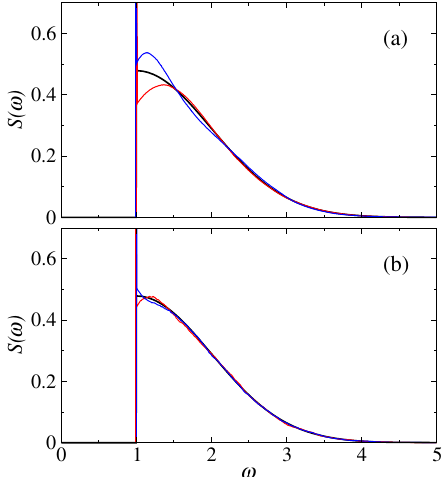
FIG. 4. Two typical SAC-computed spectral functions (red and blue curves, obtained with different noise realizations) compared with the underlying true synthetic spectrum (thicker black curve, with the half-Gaussian containing 60% of the weight). The parameters of the spectrum are the same as in Fig. 6. The noise levels are 10 − 5 and 10 − 6 in panels (a) and (b),